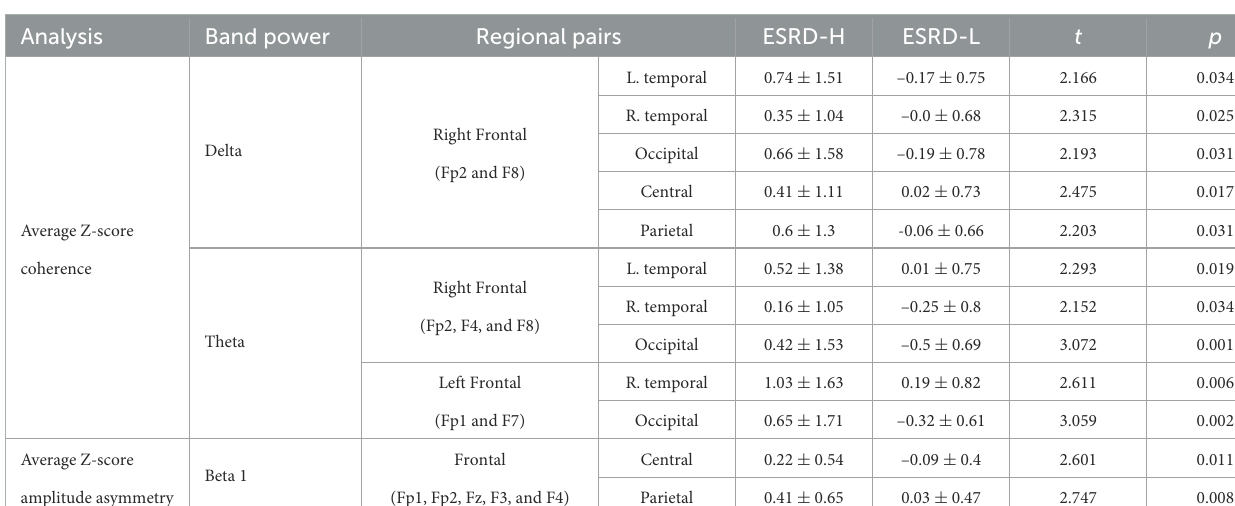
TABLE 5 The regional comparison in the bivariate QEEG analysis.